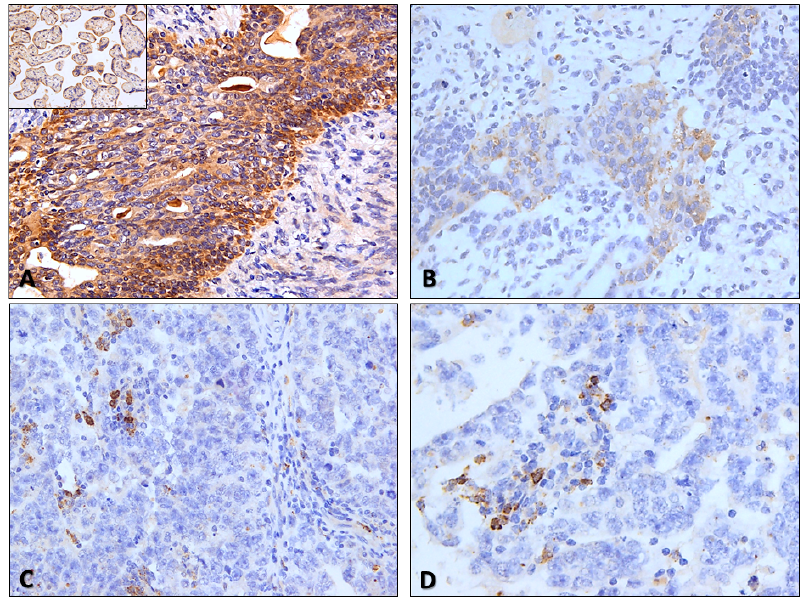
Figure 2. Illustrative examples of CTLA-4 staining in testicular germ cell tumors. ( A) and ( B) CTLA-